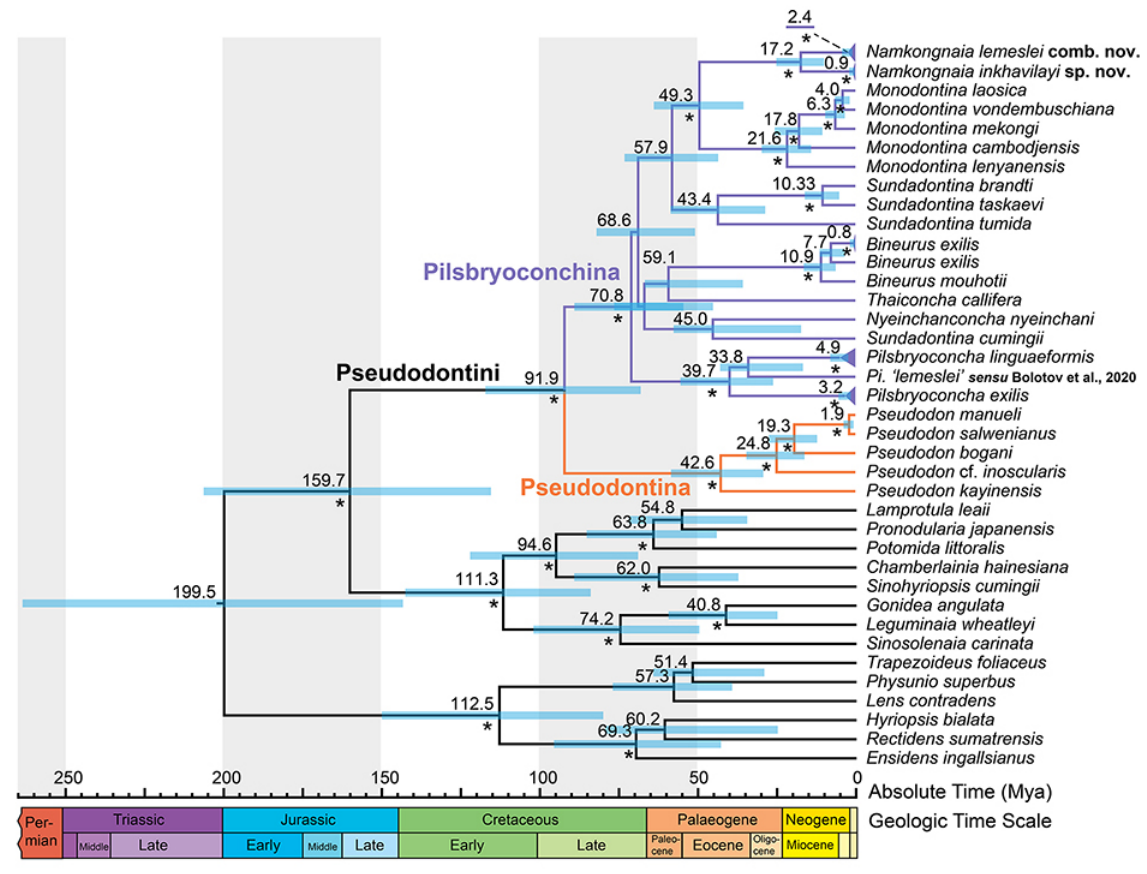
Fig. 2. Time-calibrated tree of the subfamily Gonideinae based on the concatenated alignment dataset of COI + 16S + 28S genes. Nodes present time estimates since the most recent common ancestor (tMRCA) in millions of years ago (Mya). Node bars indicate 95% highest posterior density interval (HPD) of the node ages. Sufficiently supported nodes (BPP > 0.95) are marked with ‘*’. The geologic time scale is according to the Geological Society of America,